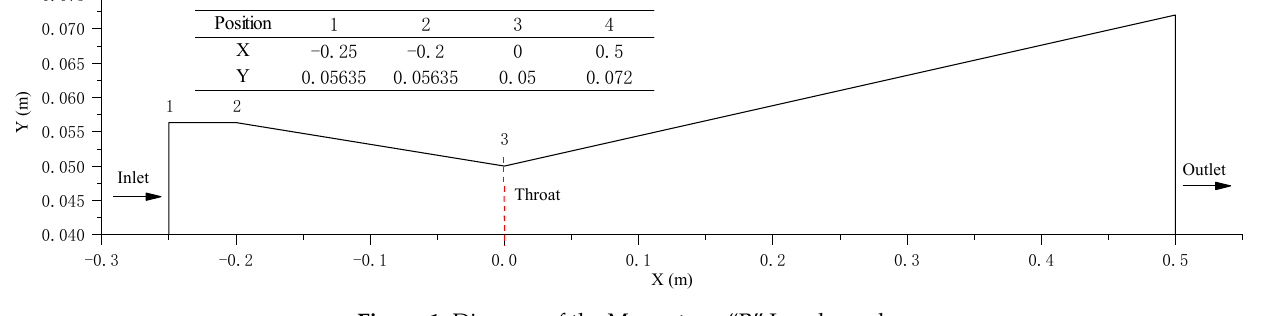
Figure 1. Diagram of the Moore type “B” Laval nozzle.